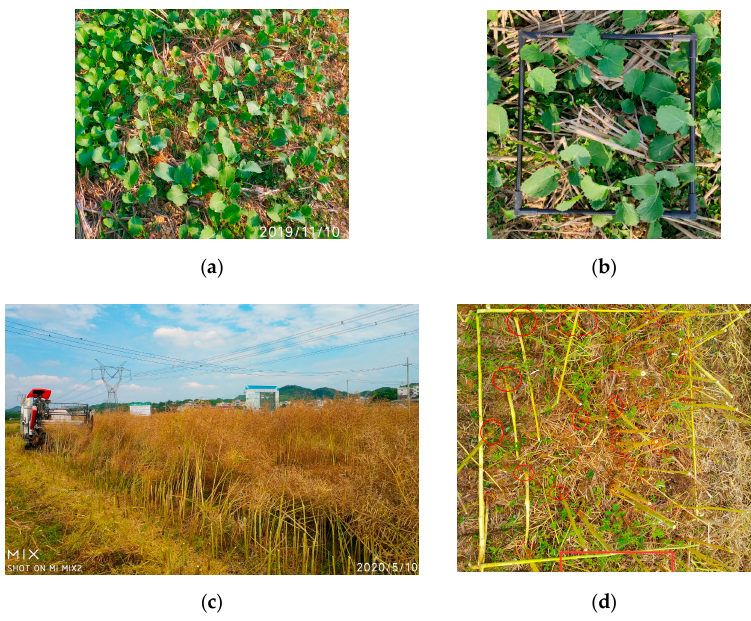
Figure 6. Subsequent investigations processes. ( a ) Monitoring seedling status; ( b ) Counting seed germination rate; ( c ) Harvesting by a combine harvester; ( d ) Counting stubbles after